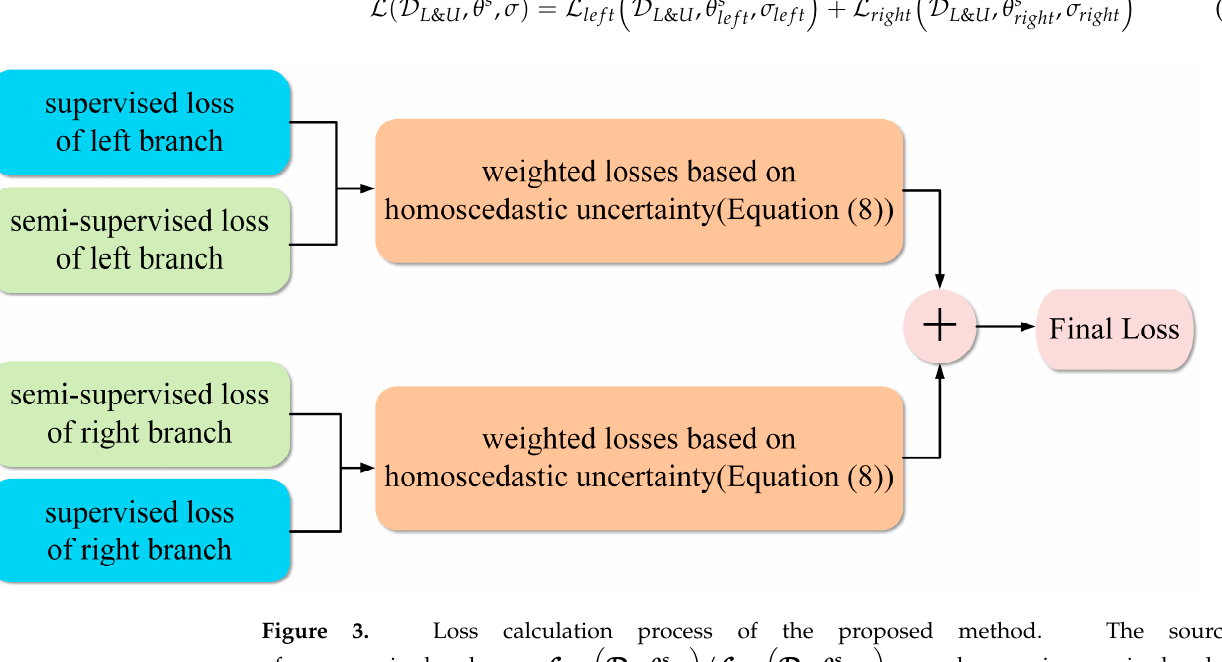
(cid:3435)𝓓 , 𝜽 𝒍𝒆𝒇𝒕𝒔 (cid:3439)/ 𝒖𝒏𝒔𝒖𝒑 𝑳&𝑼